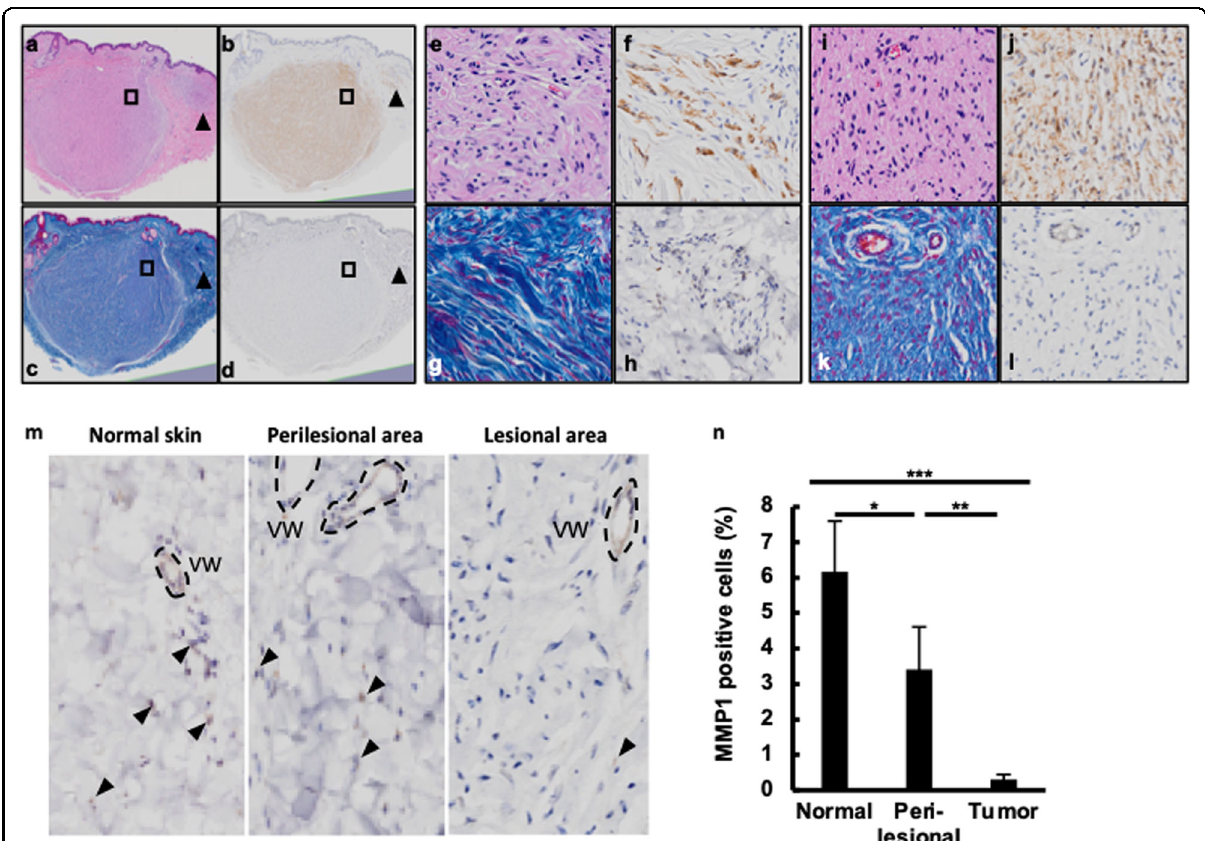
Fig. 1 MMP1 expression was downregulated in cutaneous tumor in neuro fi bromatosis type 1 patients. Biopsy samples of cutaneous tumor were taken from the dermis of an NF1 patient and subjected to hematoxylin and eosin ( a , e , i ), S100 ( b , f , j ), Azan – Mallory ( c , g , k ), and MMP1 staining ( d , h , l ). Representative images of the tumor are shown in a – d , and magni fi ed images of the squares in a – d are shown in i – l . The arrowheads show the early lesions of the peripheral regions, and their magni fi ed images are shown in e – h . m , n Cutaneous biopsy samples of normal skin, perilesional normal skin, and tumor lesion were taken from fi ve NF1 patients, on which MMP1 staining was performed. Arrowhead: MMP1-expressing cells. VW: blood vessel wall. n MMP1-positive cells were counted from three images of each section (normal skin, perilesional normal skin, and tumor); mean (with SEM) percentage of positive cells from fi ve patients is shown ( n =